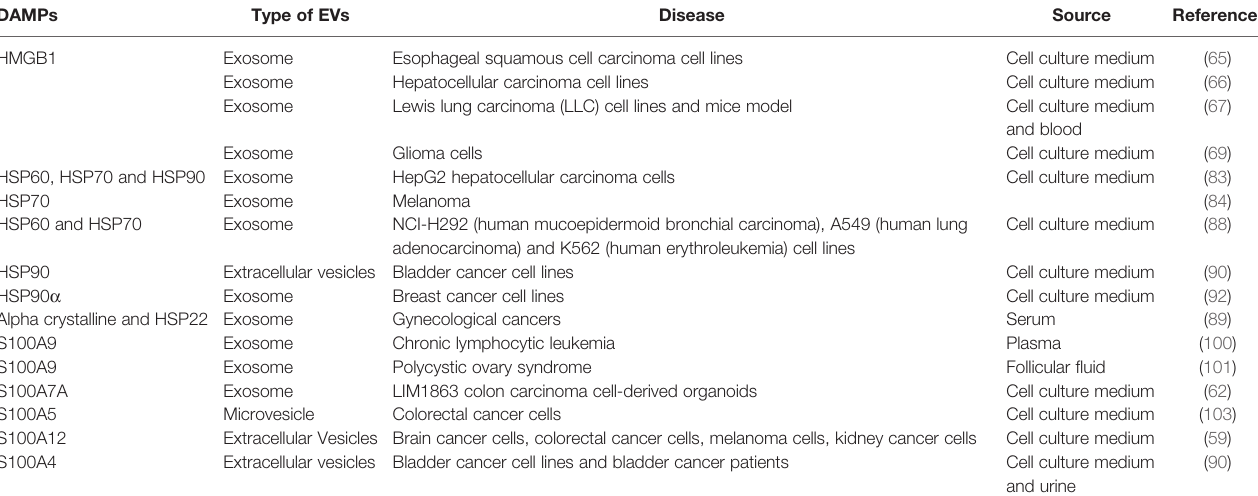
TABLE 1 | A list of some of the reported studies that have shown the presence of DAMPs within EVs. DAMPs